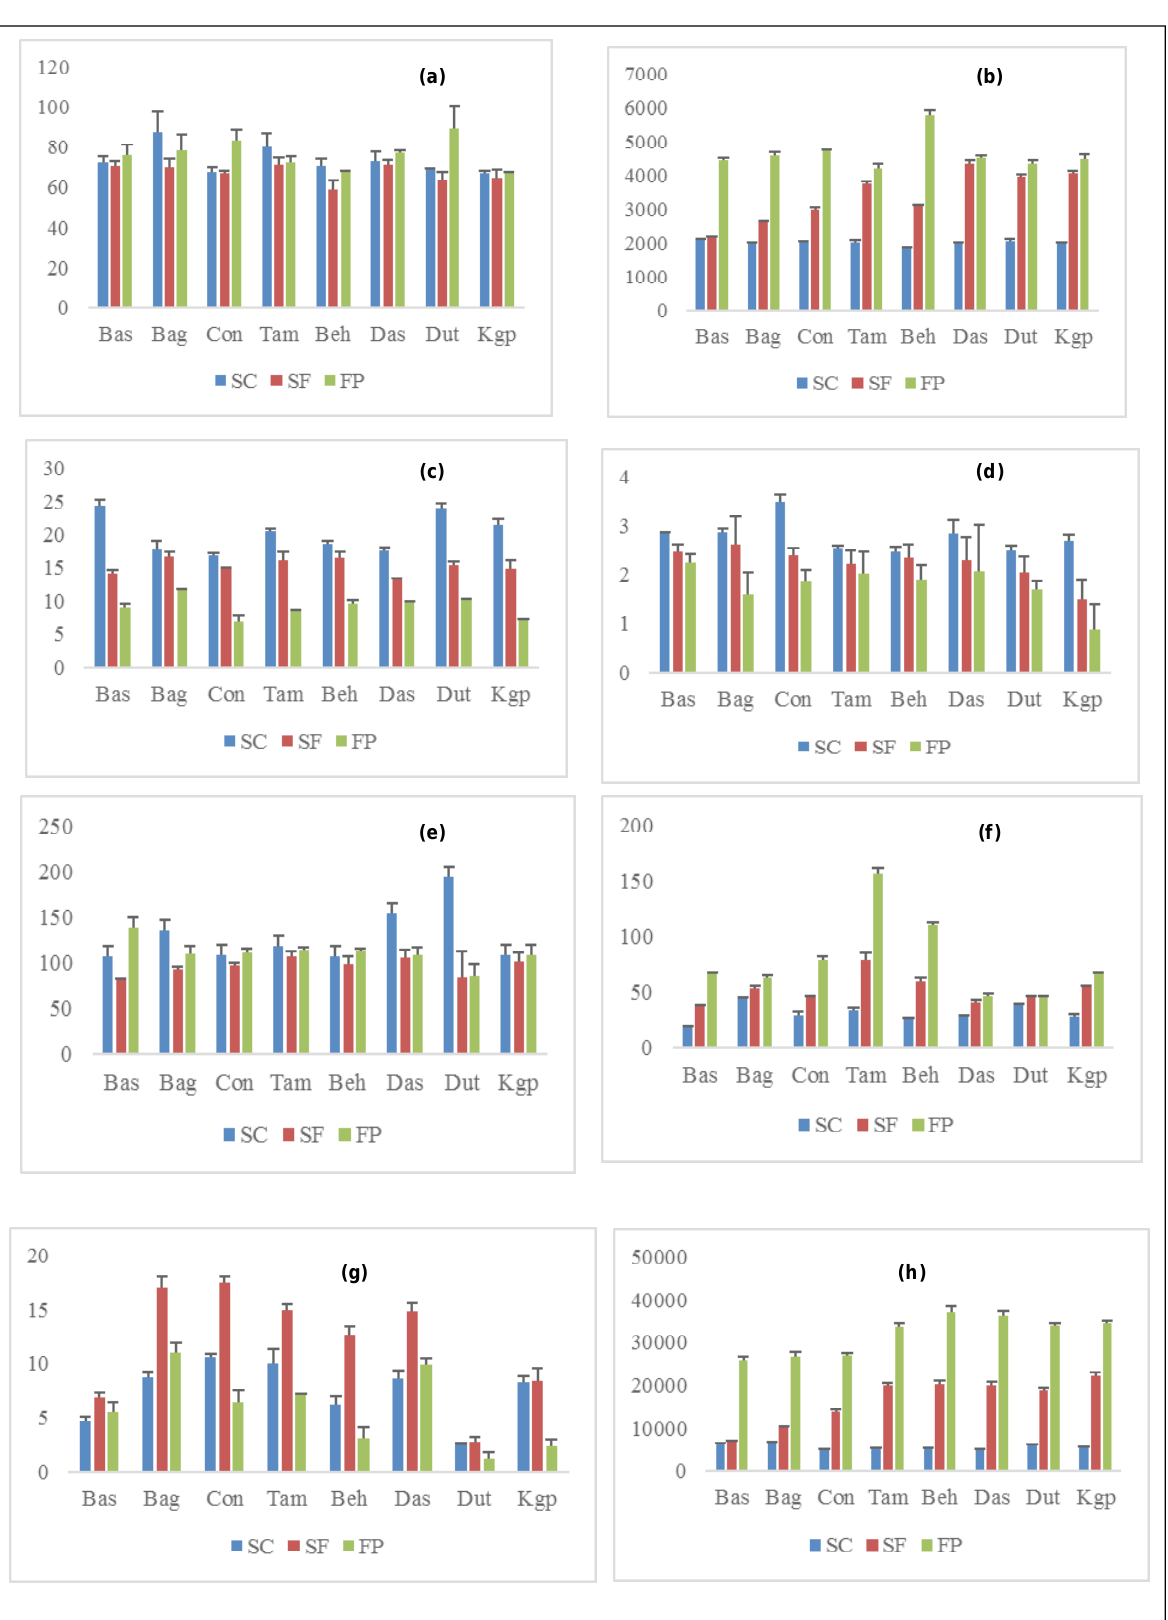
Figure 2: Graphical representation of variations in trace elemental content in different parts of fruits across the different aras- (a) Barium, (b) Calcium, (c) Copper, (d) Cromium, (e) Iron, (f) Manganese, (g) Nickel, (h) Potassium, (i) Rubidium, (j) Strontium, (k) Sulfur, (l)